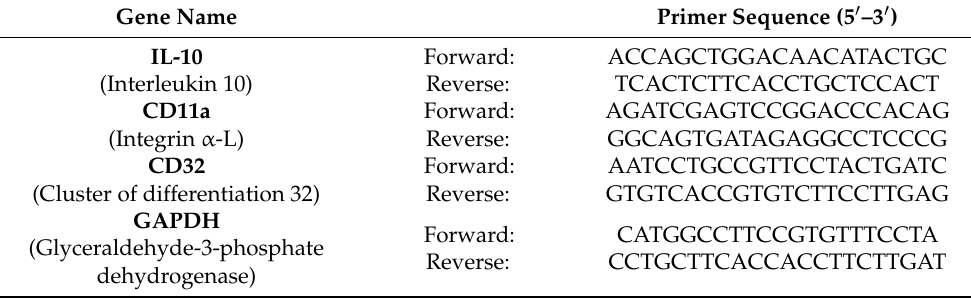
Table 1. Primer pairs and their